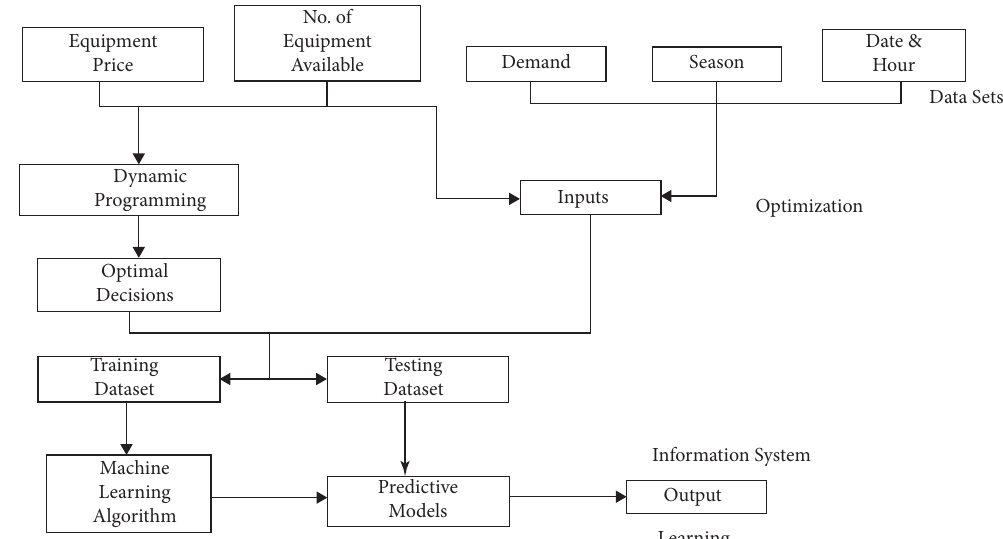
Figure 3: Supply-demand